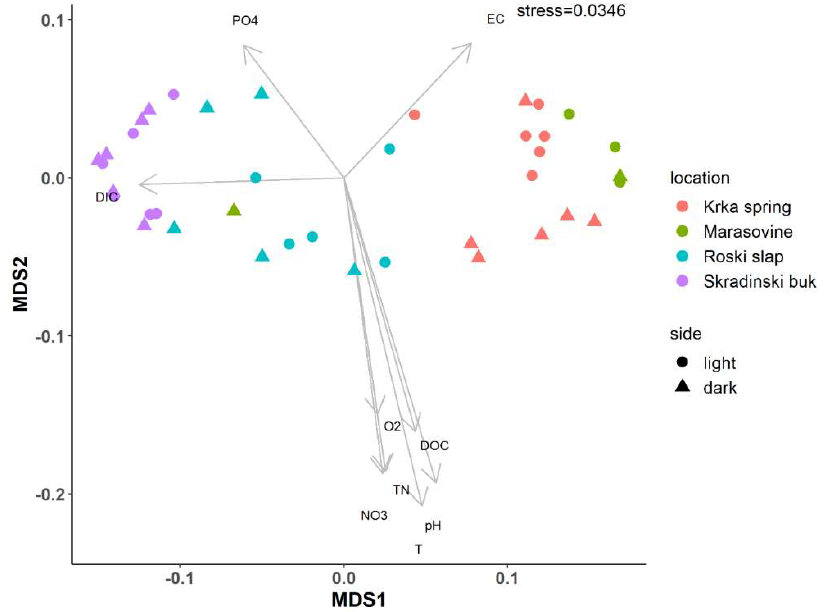
Figure 3. Non-metric multidimensional distance scaling (NMDS) analysis of the Unifrac distance indices of the ciliate community at OTU level with environmental parameters (DIC = dissolved inorganic carbon, DOC = dissolved organic carbon, EC = conductivity, N-NO 3 , O 2 = oxygen saturation, pH, PO 4 = phosphates, T = temperature, TN = total nitrogen).